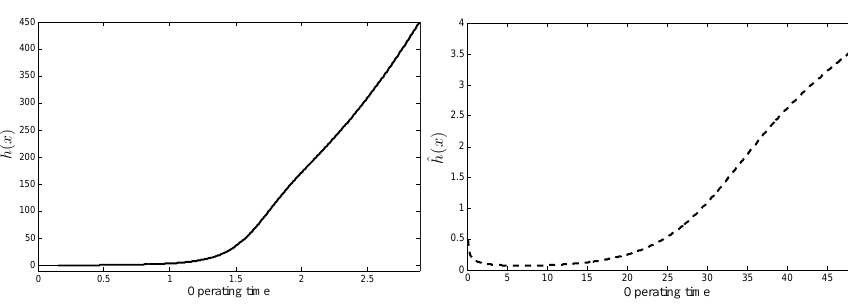
Figure 7 – Plots of the estimated failure rate functions of the OWG distribution for data sets 1 and 2.